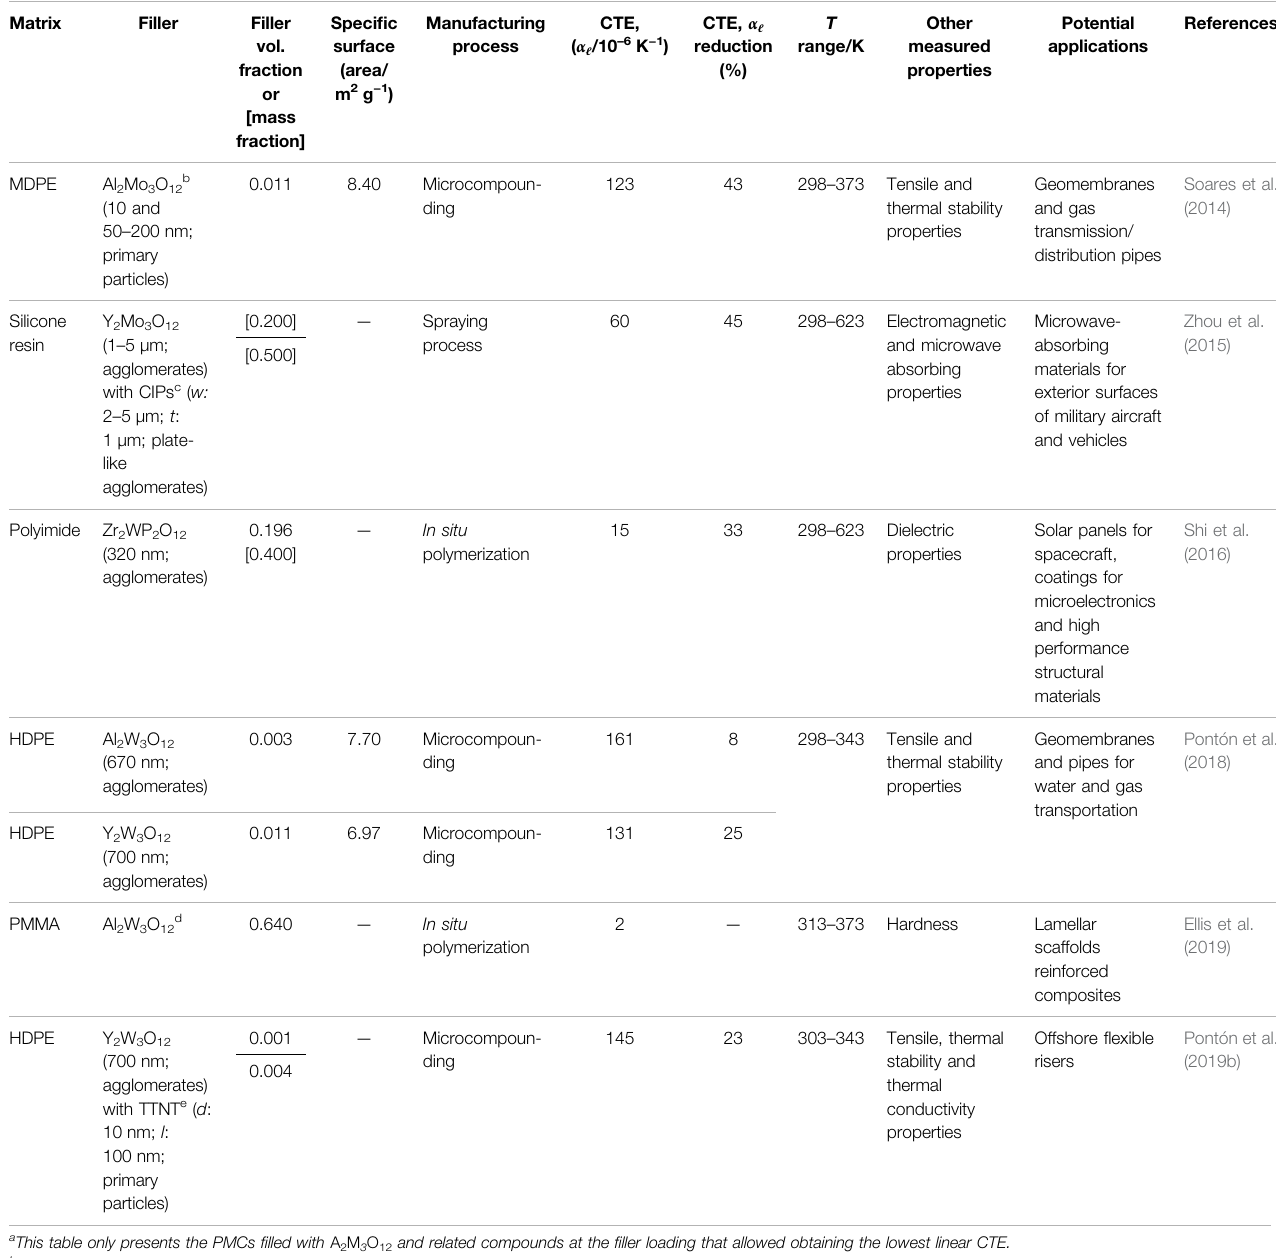
TABLE 3 | Polymer matrix composites (PMCs) fi lled with A 2 M 3 O 12 and related materials, their manufacturing process, linear CTE and potential applications a . Matrix Filler